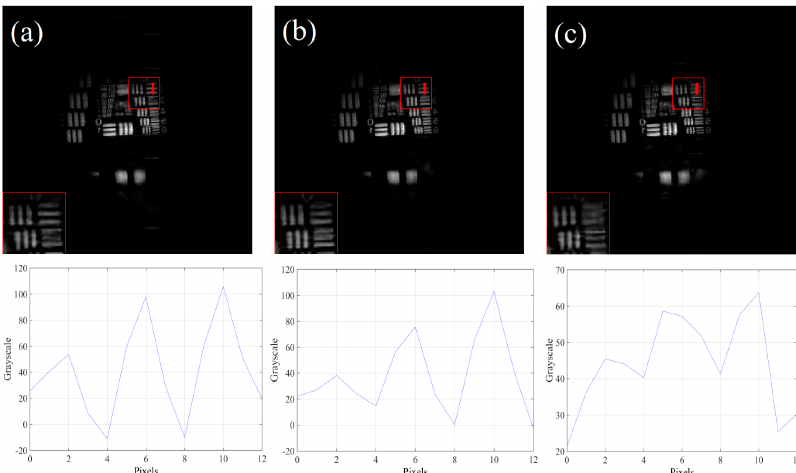
Figure 6. The reconstructed results under different measurement matrices, and the vertical grayscale change curves are given correspondingly. ( a ) Sparse binary random matrix. ( b ) m sequence matrix. ( c ) True random number matrix. The compressive sampling ratios are 0.5.